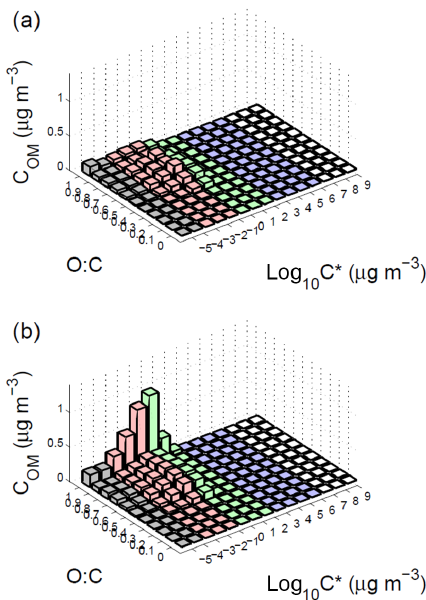
Figure 6. The distribution of mass is plotted over the 2D-VBS space for multi-generation products, after 10h of OH aging of 100µgm − 3 α -pinene + ozone at β = 0 . 15. (a) The 1N layer, where the mass of products is highest in the moderately oxidized and semi-volatile ranges. (b) The 0N layer, where the mass is highly oxidized and lower in